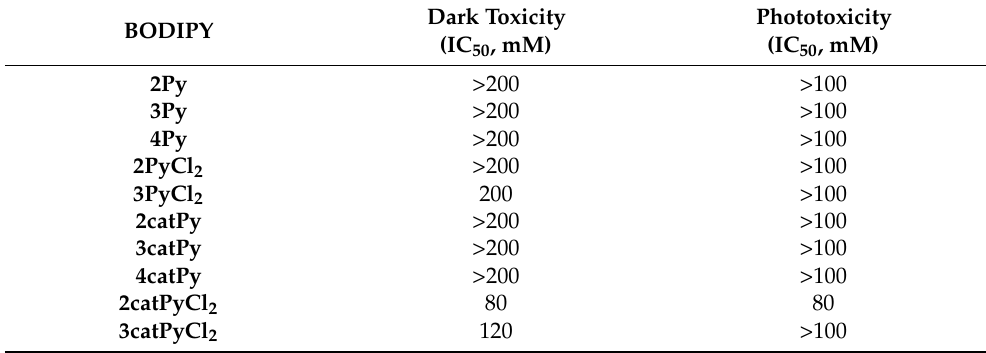
Table 4. Dark and photo (1.5 J/cm 2 ) cytotoxicity of BODIPYs toward HEp2